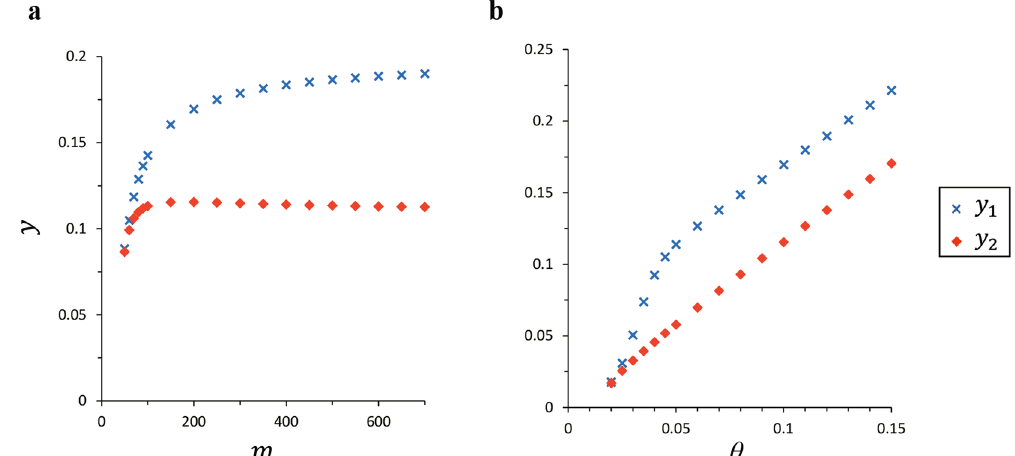
Figure 5. Sensitivity analysis of y 1 and y 2 . The blue cross and red diamond denote the transition proportion of territory breakdown y 1 and formation y 2 , respectively. ( a ) y 1 and y 2 depending on m . All the model parameters excluding m are the same as the conditions of the population dynamics in Fig. 2 and hysteresis in Fig. 4. As the model parameter m becomes larger, the difference between y 1 and y 2 becomes larger. ( b ) y 1 and y 2 depending on θ . All the model parameters excluding θ are the same as the conditions of the population dynamics in Fig. 2 and hysteresis in Fig. 4. As the model parameter θ becomes larger, the difference between y 1 and y 2 becomes